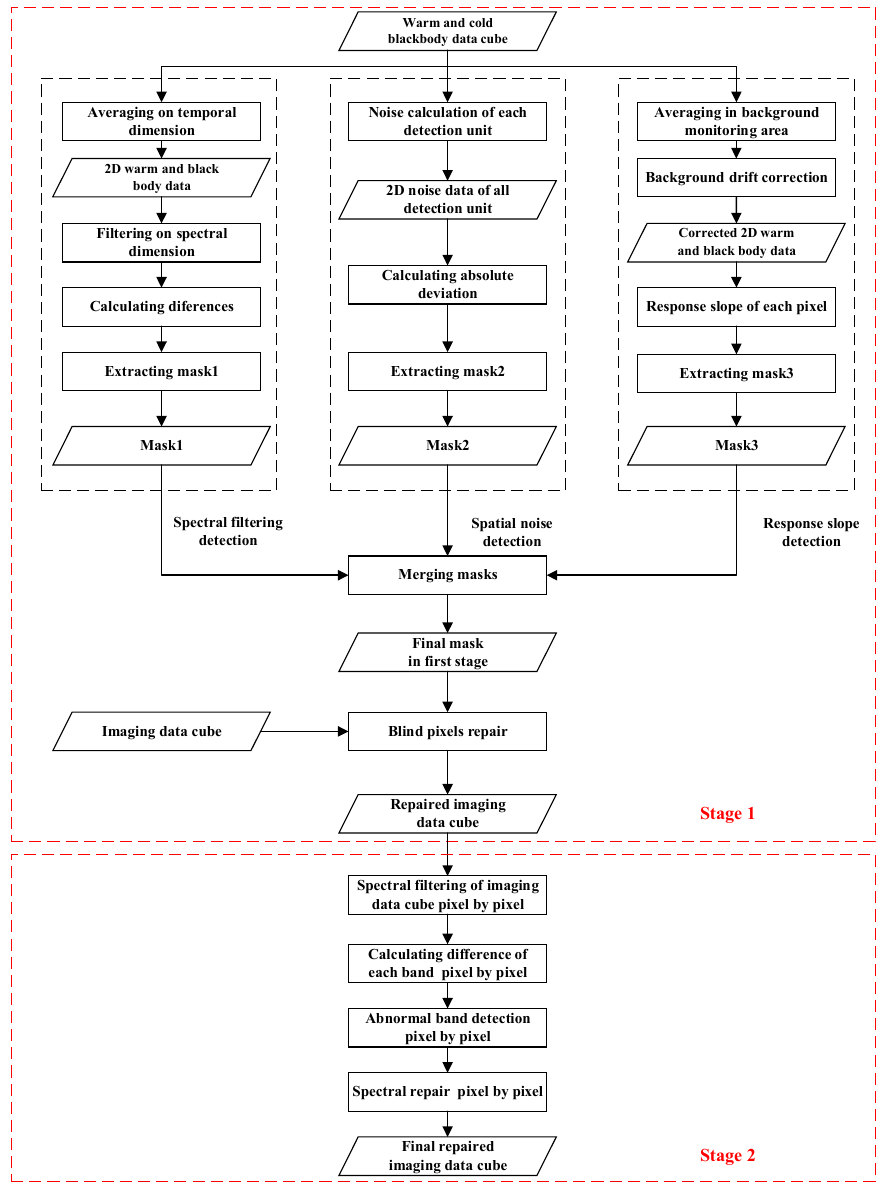
Figure 3. Technical flow